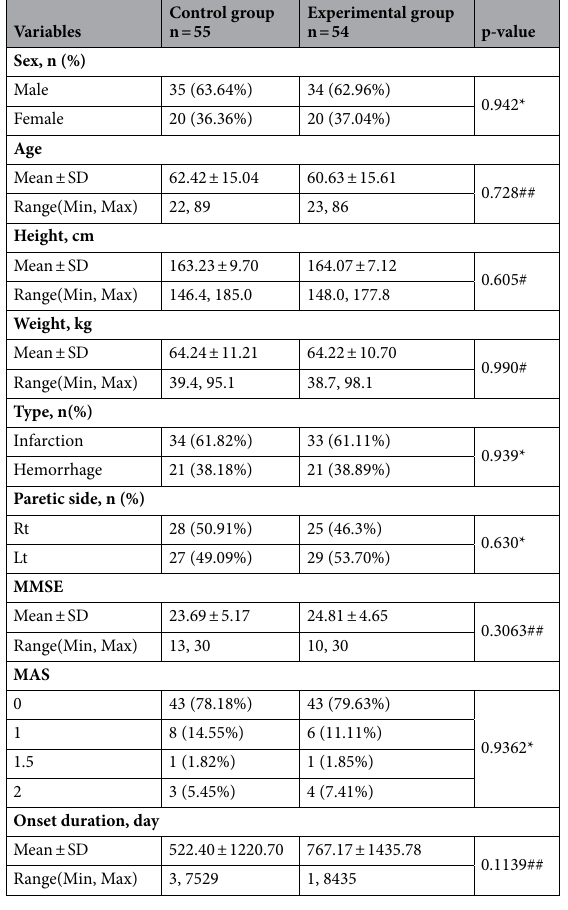
Table 1. The baseline characteristic of the experimental and control group. MMSE Mini-mental state examination, MAS Modified Ashworth Scale. *p-value obtained from Chi-square test. # p-value obtained from Student’s t-test. ## p-value obtained from Wilcoxon rank sum test.